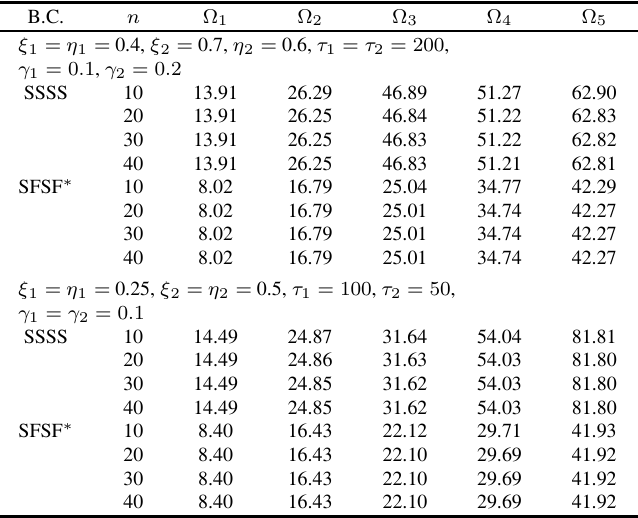
Table 2 The convergence study of the fi rst fi ve coupled eigenfrequencies for square plates with two sprung masses in respect to the number of terms ( n ) used B.C. n Ω